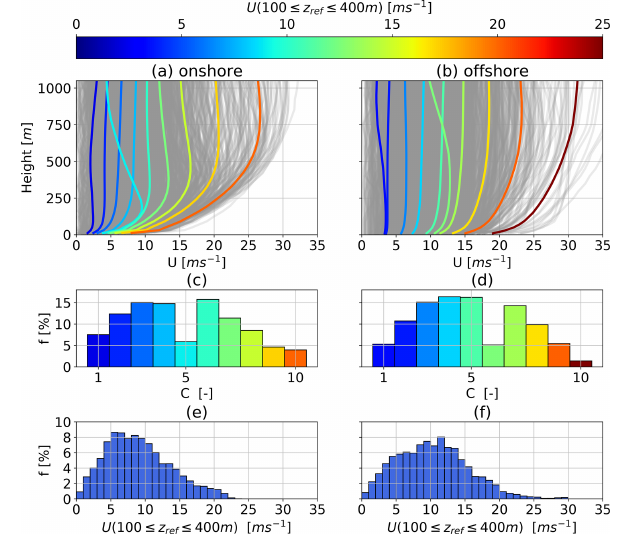
Figure 1. Topographic map of northern Germany with the repre- sentative onshore (Pritzwalk) and offshore (FINO3) locations high- lighted with black dots and labeled.